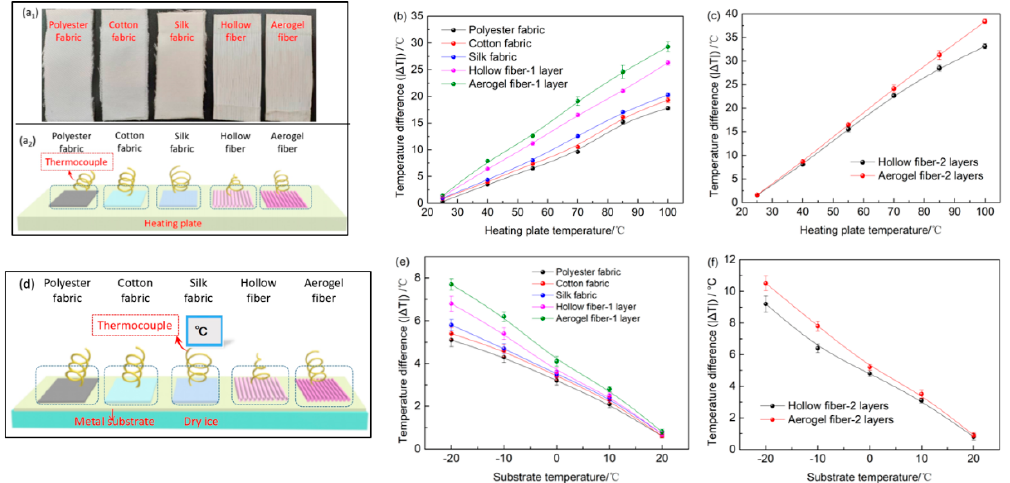
Figure 5. Thermal insulation properties of the hollow and aerogel fiber mats under hot and cold environments. ( a 1 ) Optical photo of samples for testing and ( a 2 ) schematic diagram of the test under hot conditions. ( b ) Temperature di ff erence ( | ∆ T | ) of the fiber surface ( T f ) and heating plate ( T h ) versus the T h for polyester fabric, cotton fabric, silk fabric, 1-layer hollow fibers and 1-layer aerogel fibers. ( c ) | ∆ T | of the T f and T h versus the T h for 2-layer hollow fibers and 2-layer coaxial fibers. ( d ) Schematic diagram of the test under cold conditions. ( e ) | ∆ T | of the T f and cold substrate ( T s ) versus the T s for polyester fabric, cotton fabric, silk fabric, 1-layer hollow fibers, and 1-layer aerogel fibers. ( f ) | ∆ T | of the T f and T s versus the T s for 2-layer hollow fibers and 2-layer coaxial fibers.